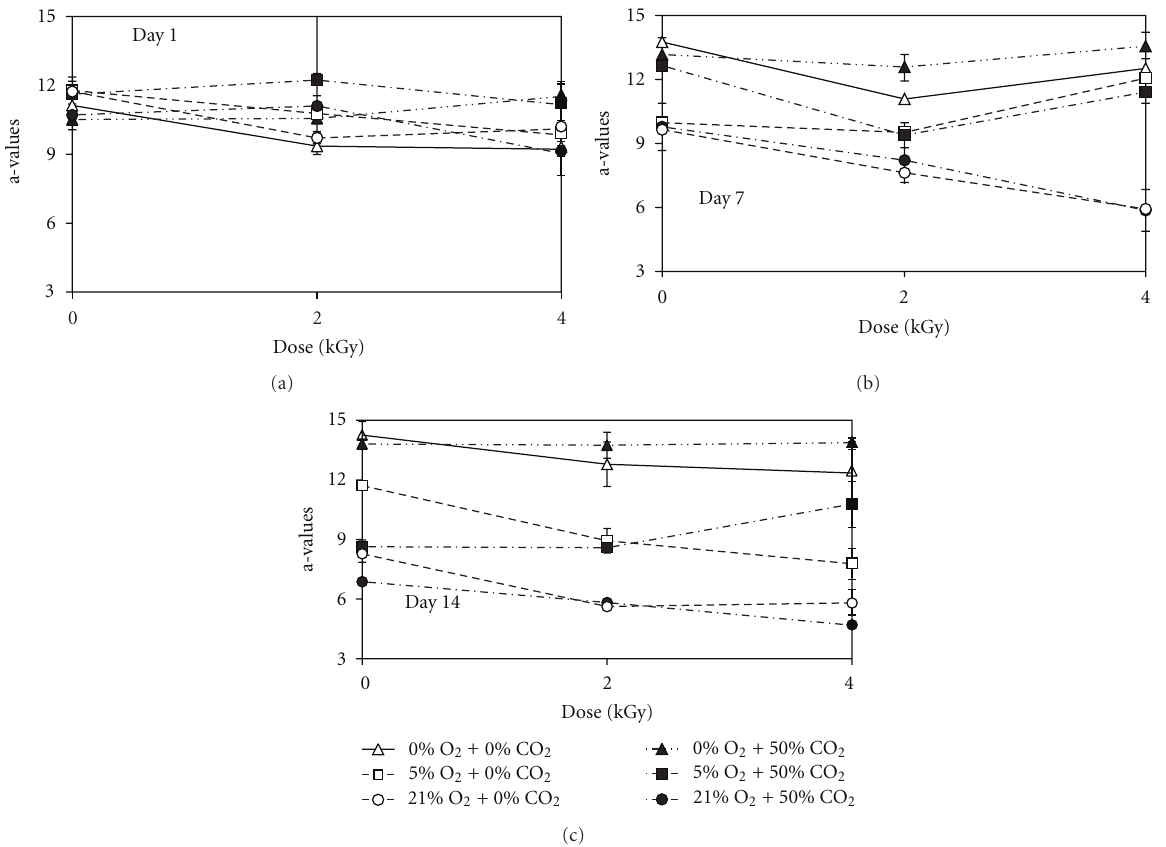
Figure 2: E ff ects of irradiation dose and O 2 and CO 2 levels in packages on a-values of ready-to-cook meatballs during storage at 3 ◦ C. Error bars represent standard